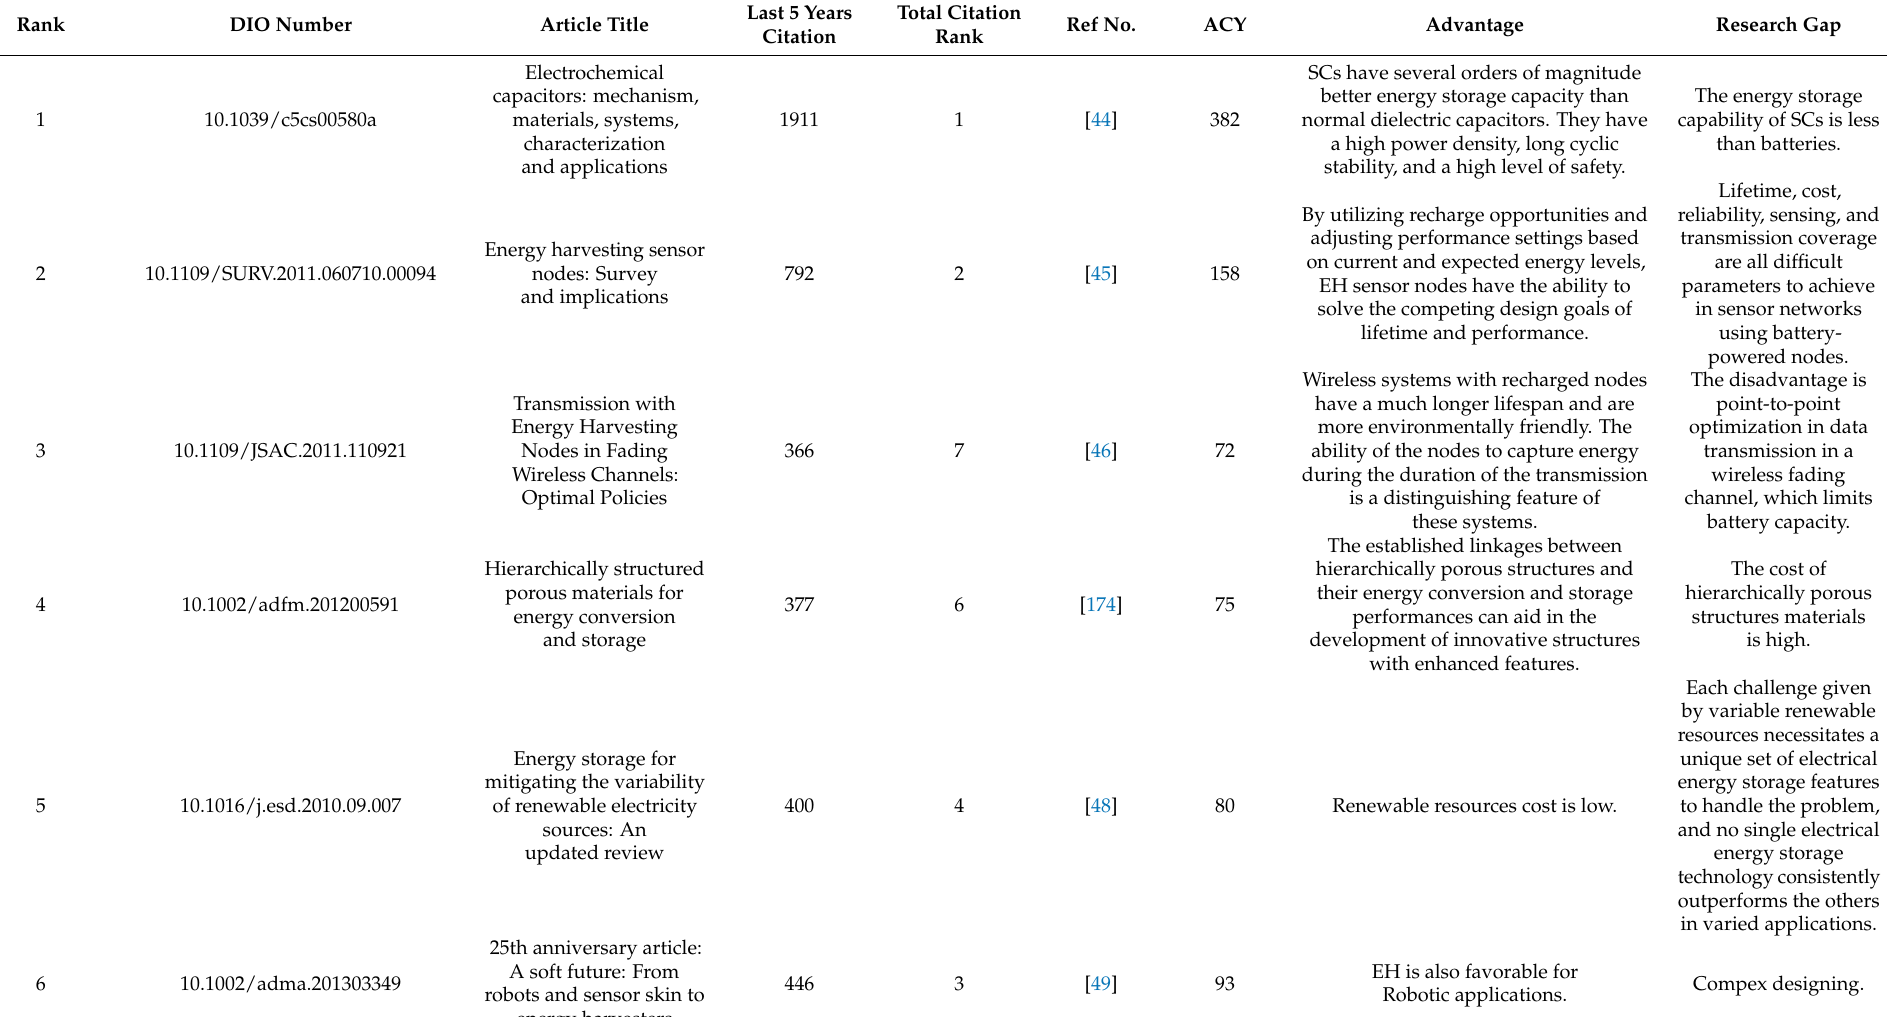
Table 3. Highly cited manuscripts in the last